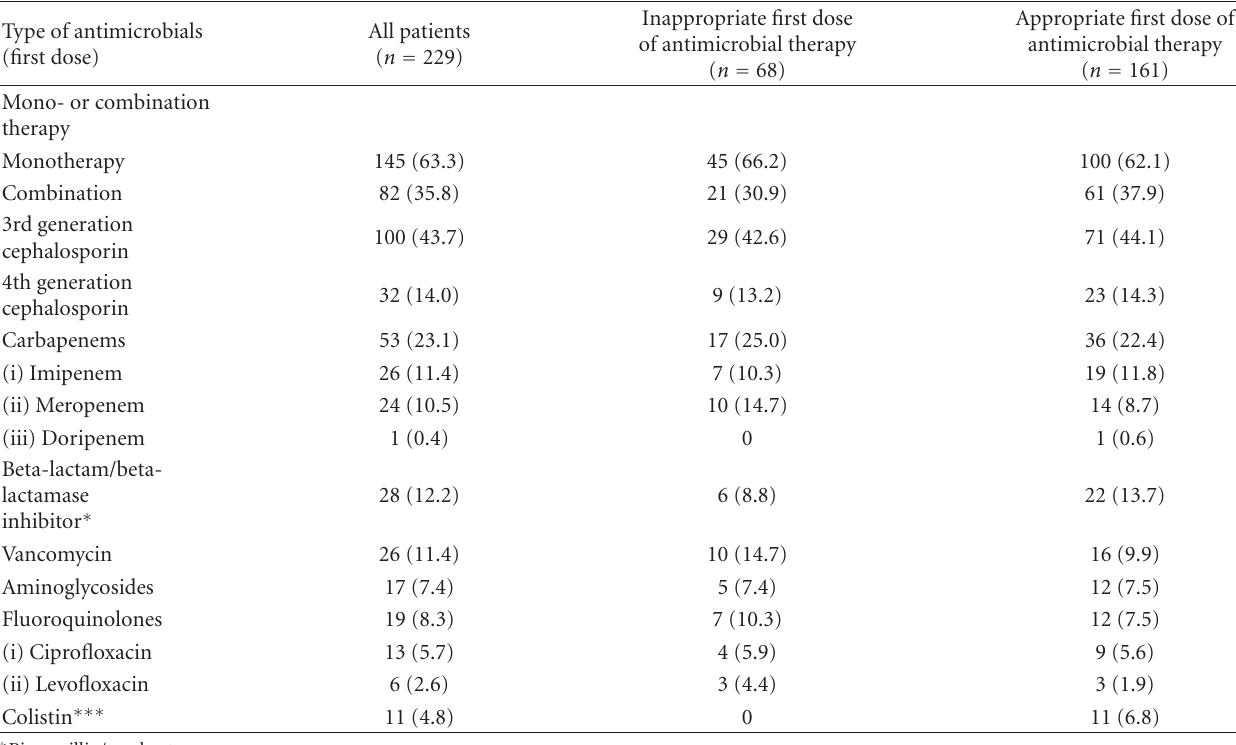
Table 4: Type of first-dose empiric antimicrobials for sepsis by appropriateness of empiric antimicrobial therapy.